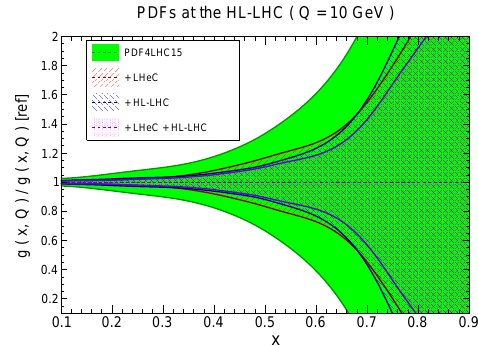
Figure 4.5: Same as Fig. 4.4, for the gluon PDF alone, with a linear